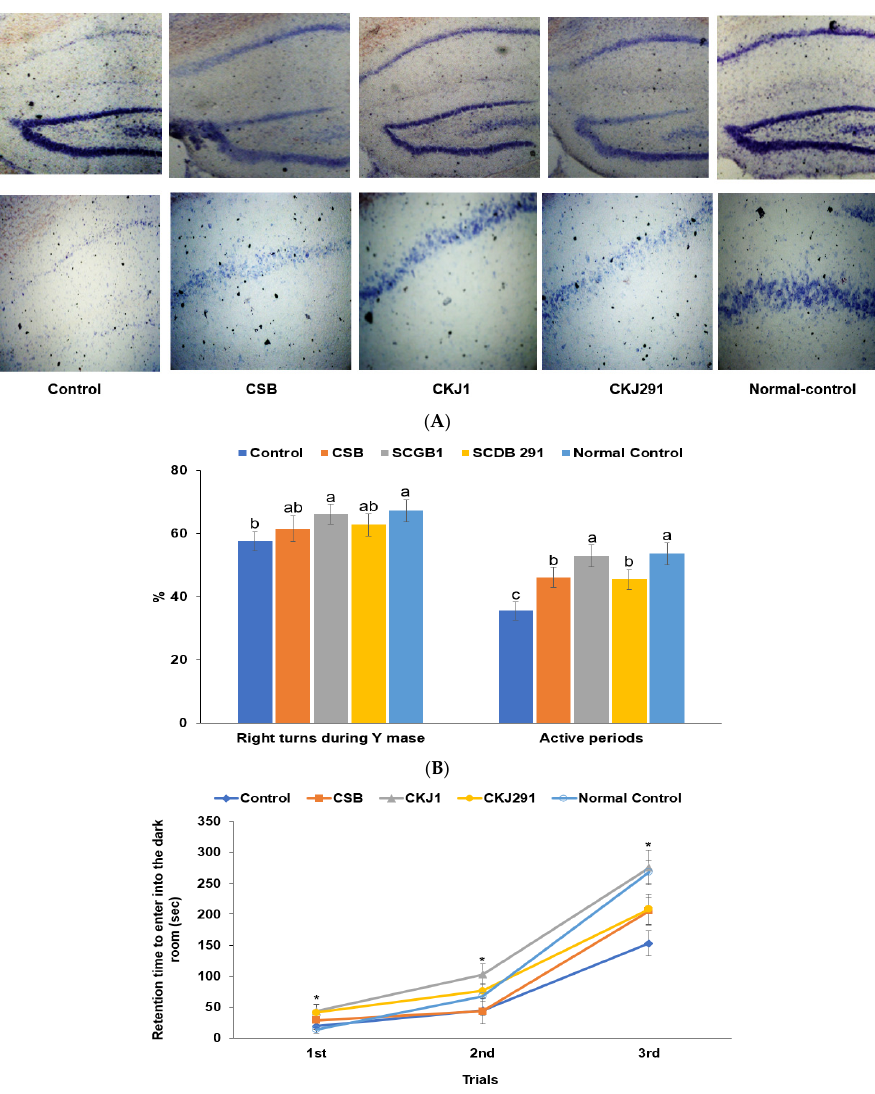
Figure 2. Brain cell death after ischemic stroke and memory loss. On the 3rd week after inducing artery occlusion, the survived cells were quantified in a cresyl violet stained brain section by densitometry ( A ). The spontaneous alternations in the Y maze and active periods in locomotive activity were measured on the 14th and 15th day after artery occlusion ( B ). The passive avoidance tests were conducted three times ( C ). Dots and bars represent means ± SD ( n = 10). * Significantly different among the groups at p < 0.05. a,b,c Means on the bars with different letters were significantly different by Tukey’s test at p < 0.05.